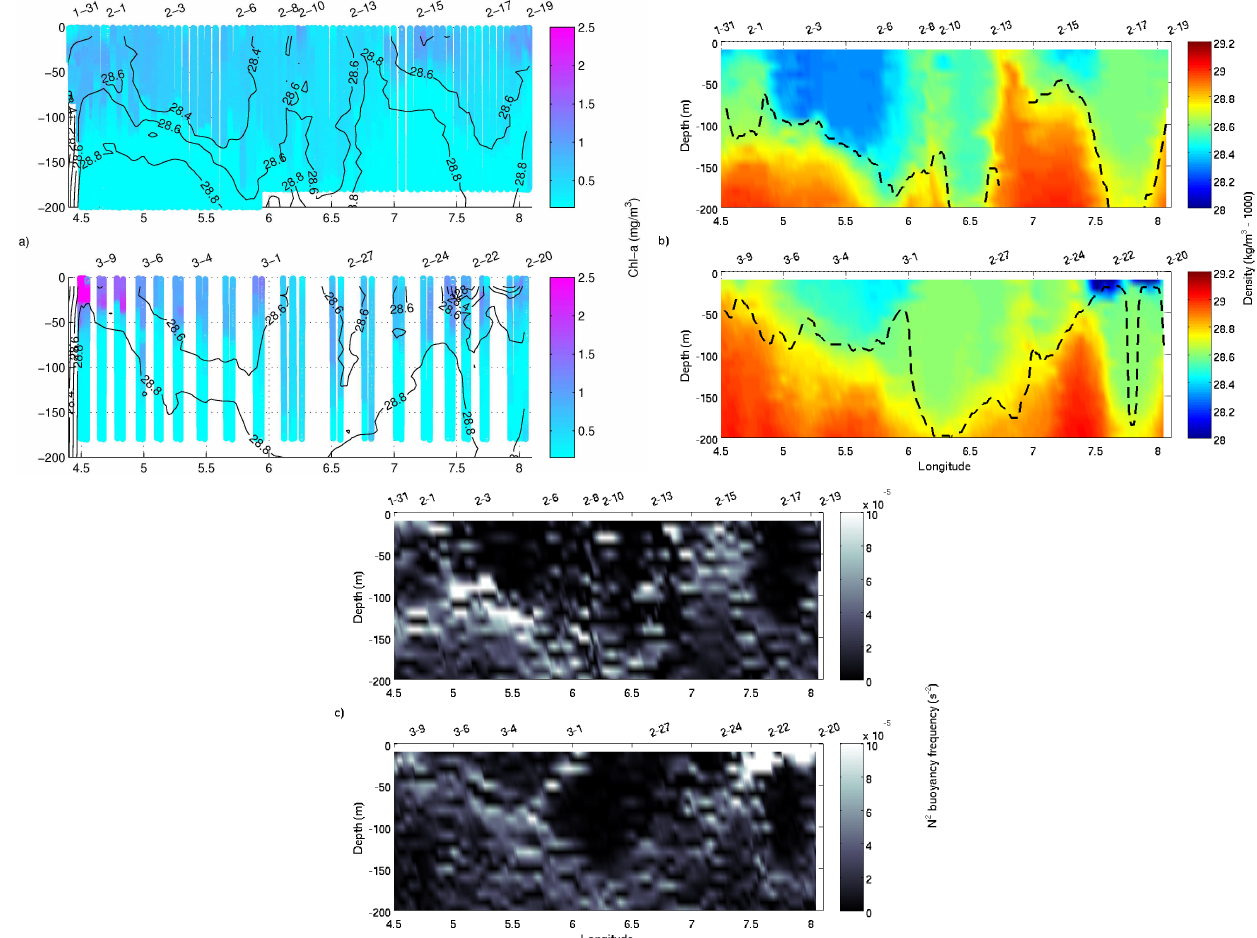
Figure 4. (a) Chlorophyll a sections with superimposed density contours obtained from in situ fluorescence observations for the outbound (upper panels) and return (lower panels) legs of the glider mission. (b) Mixed layer depth (dashed contour line), as calculated from observed densities, superimposed on the density sections of the outbound (upper panels) and return (lower panels) legs of the glider mission; (c) The distribution of the Brunt–Väisälä (buoyancy) frequency ( s 2 ). The panels are provided with dates (MM-DD) to facilitate